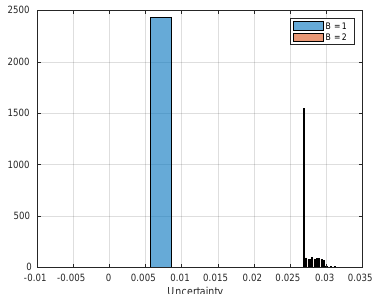
Figure A19. Histograms for the conclusion of the effect of factor B on the expected uncertainty performance, represented for the two levels of the factor.